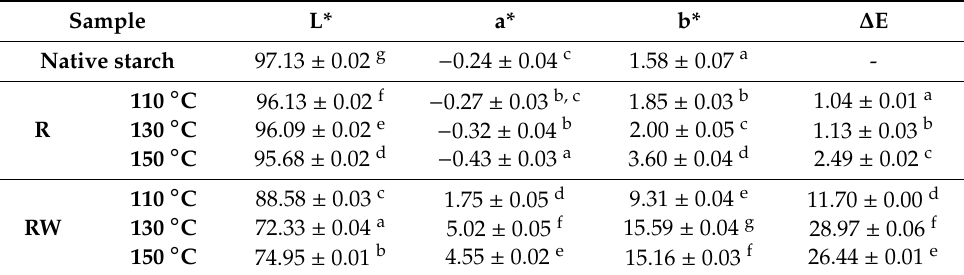
Table 3. Color di ff erences determined in the modified starch